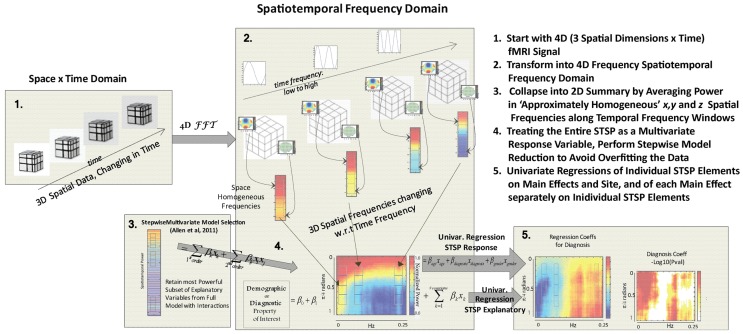
Schematic outline of methods.